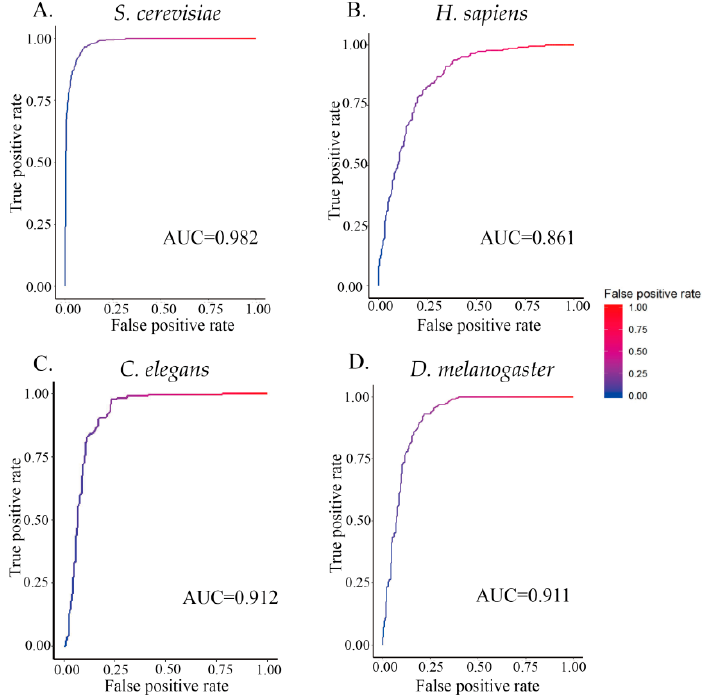
Figure 4. AUC obtained from 10-fold cross-validation. ( A – D ) represent the maximum AUC or areas under the ROC curve (0.982, 0.861, 0.912, and 0.911) for S. cerevisiae, H. sapiens, C. elegans, and D. melanogaster , respectively.